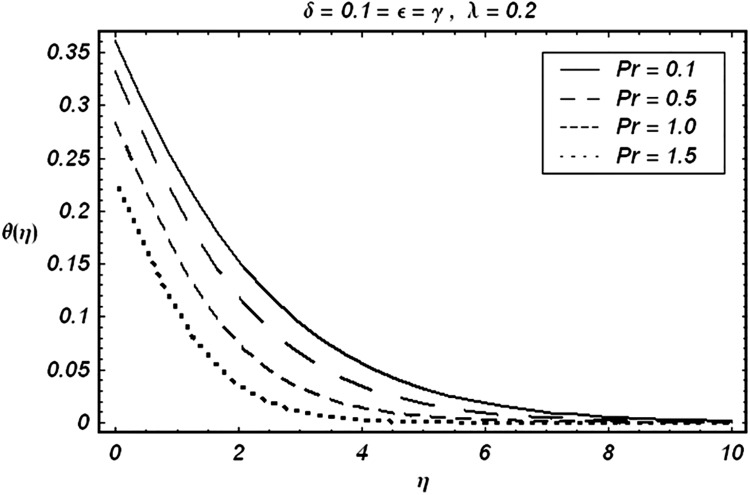
Variation of Pr on θ.